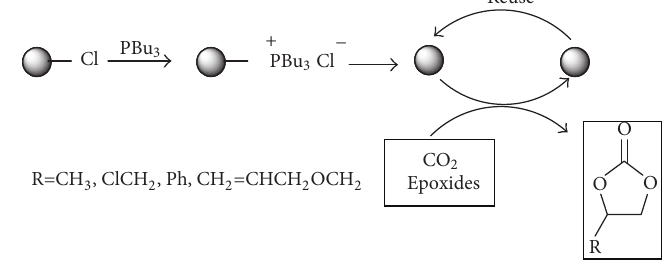
S 1: Preparation of PS-QPS and cycloaddition reaction of CO